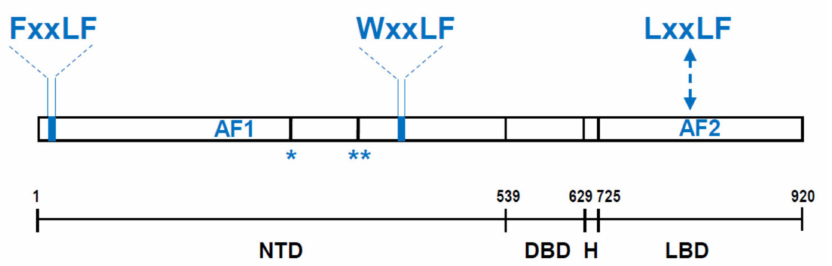
Figure 1. AR domain and motif organization. AR consist of an N -terminal domain (NTD) which contains a ligand-independent transcriptional function (AF) AF-1, a central DNA binding domain (DBD) and a C-terminal ligand-binding domain (LBD) which harbors the ligand-activated AF-2. DBD and LBD are connected by a hinge (H) region. FxxLF, WxxLF and LxxLF motifs represent short amino acid sequences relevant for AR domain interactions, AR transcriptional activity and AR-coregulator interaction, as discussed in the text. Numbers represent amino acids in AR protein, for which numbering is based on NM_000044.2. * and ** indicates a short 14 amino acid stretch and a proline rich region that has been used as bait in 2 hybrid screening or phage display assays in references He et al., 2004 and Blessing et al., 2015 respectively.